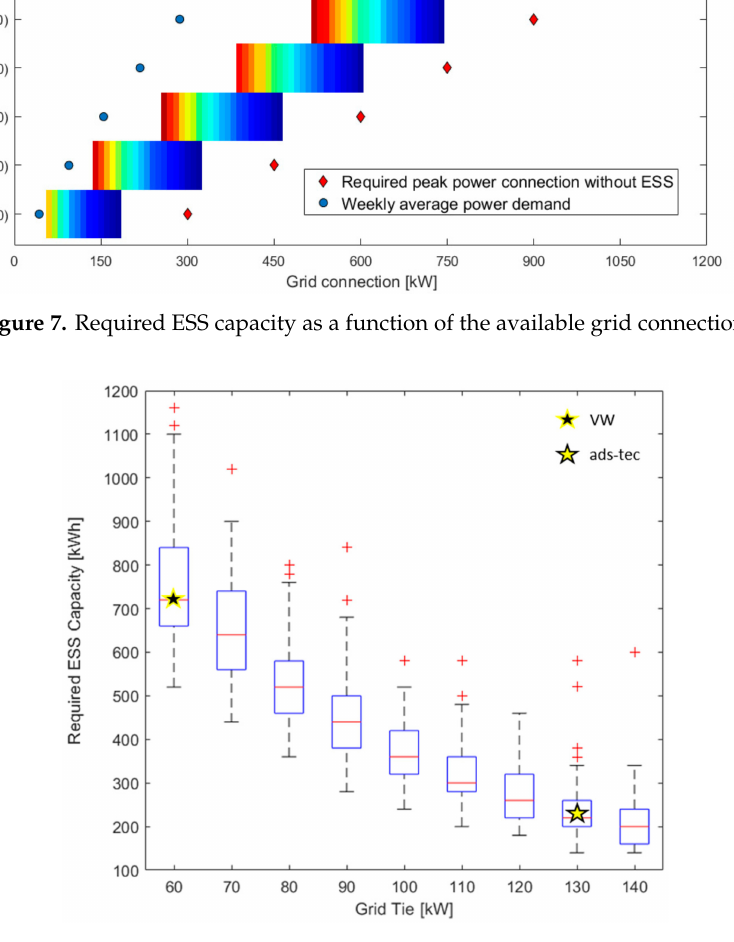
Figure 8. Dispersion of the results for two charging points with 150 charging events per